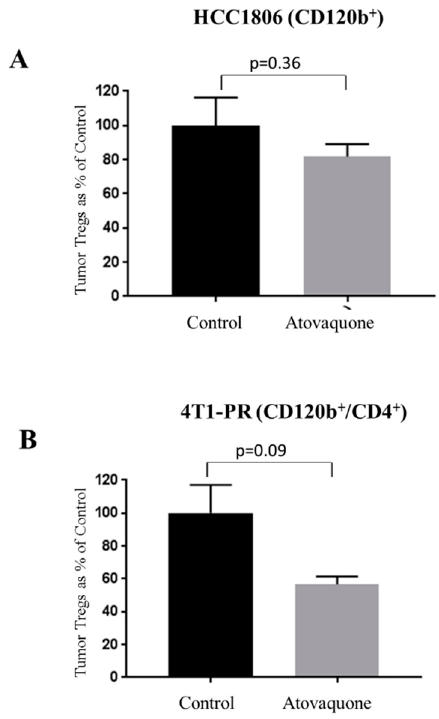
Figure 3. Atovaquone suppresses regulatory T cells (Treg) in HCC1806 and 4T1-PR tumors. Tumors were removed from mice bearing HCC1806 and 4T1-PR tumors at the end of the experiment. Tumors from control and atovaquone-treated groups were processed and suspended into single-cell suspension, using a tumor dissociator kit. Modulation of Treg cells was monitored by immunostaining with CD120b/CD4 and analyzed by flow cytometry. ( A ) Percent Tregs from control and atovaquone-treated groups stained with CD120b in HCC1806 tumor cells. ( B ) %Tregs double stained with CD120b and CD4 mouse specific antibodies in 4T1PR tumor cells. Values were plotted as mean ± SEM from n = 4 samples.